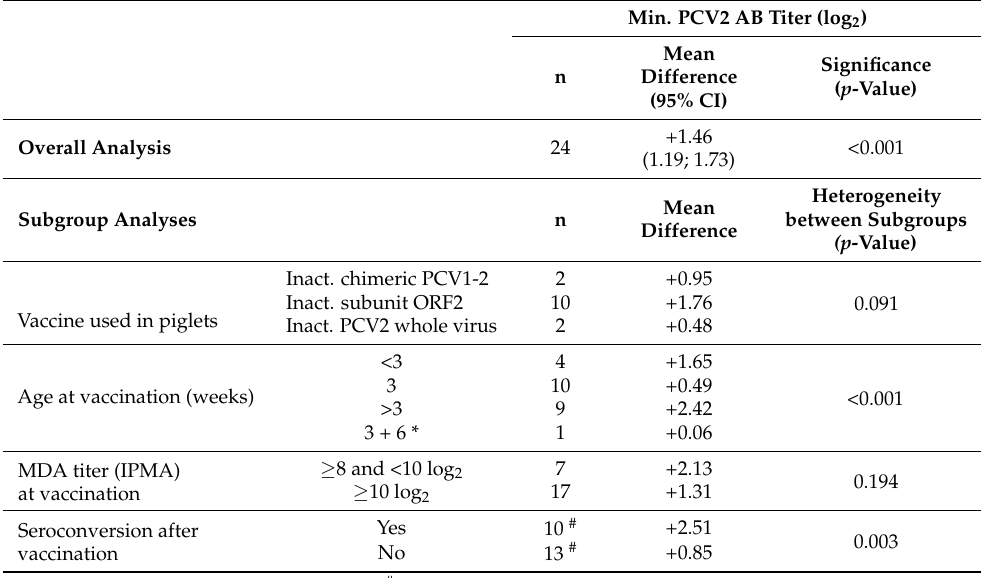
Table 5. Differences in serological parameters (minimum AB titer in serum measured at any time point during the study observation period) between vaccinated and unvaccinated pigs with high levels of MDA at the age of vaccination against